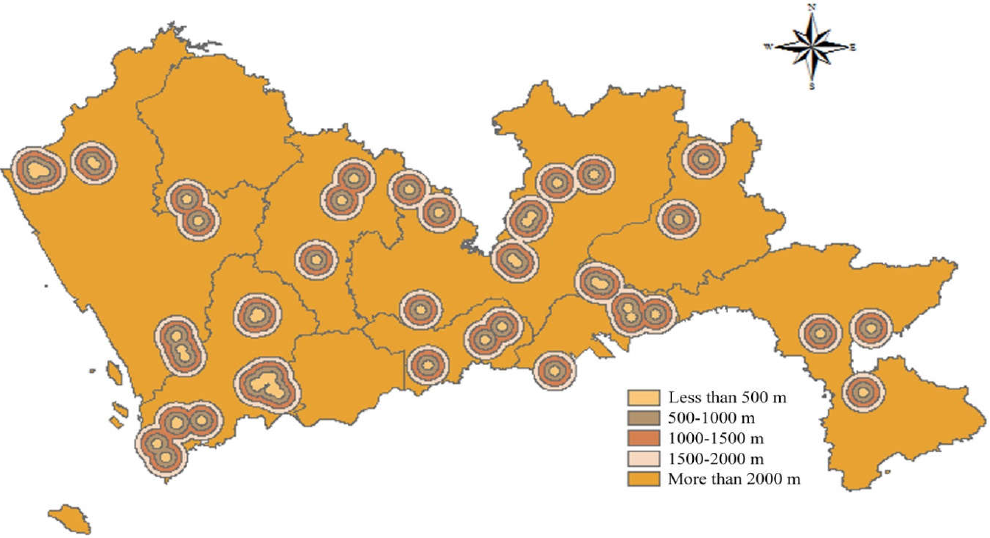
Figure 9. Map of distance to cultural attractions.